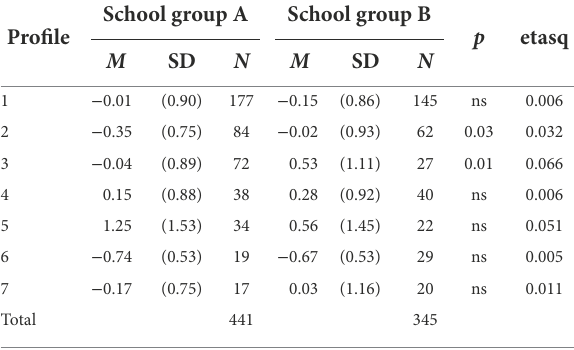
TABLE 6 Effects of profile and school group on total influence on peers.